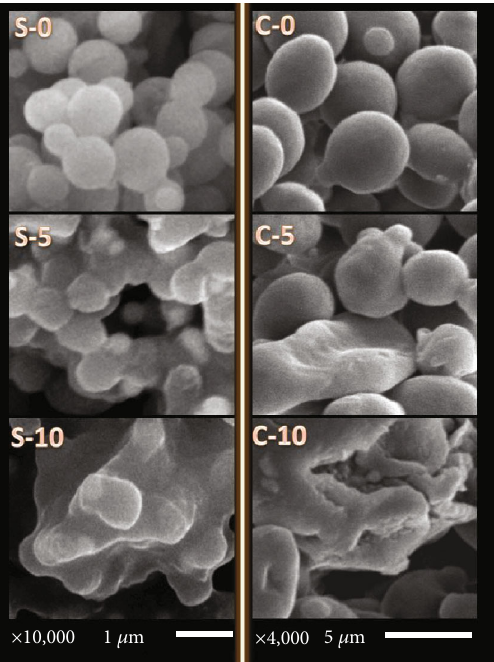
Figure 4: Consequences of exposure to nanochitosan/henna extract composite on the constructions of skin pathogens C. albicans (C) and S. aureus (S) after 0, 5, and 10h of treatment.